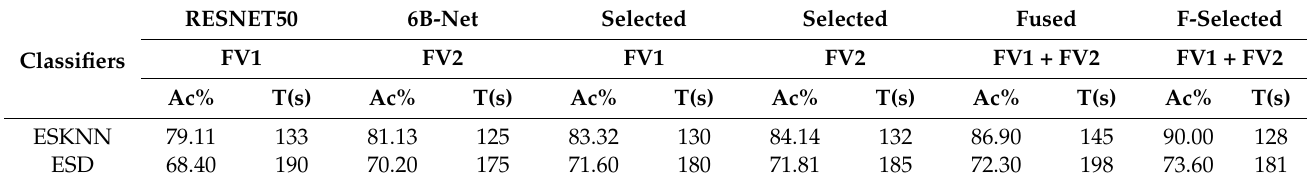
Table 2. Results using proposed feature fusion and selection-based method on BreaKHis dataset with eight classes and five-fold validation, where Ac% represents the accuracy in percent, and T(S) represents the training time in seconds.